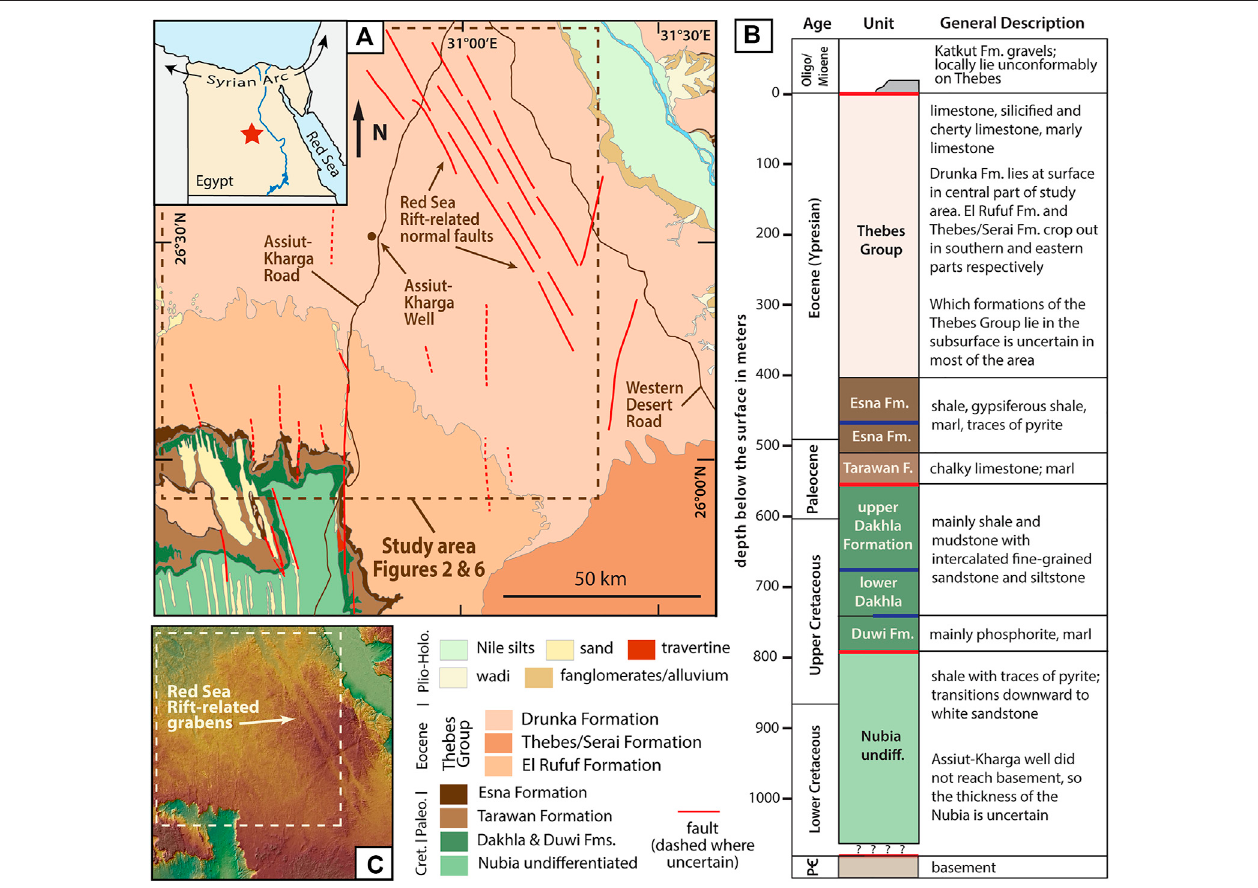
FIGURE3|(A) GeneralizedgeologicmapadaptedfromKlitzschetal.(1987),Riadetal.(2005),andGhobrial,1967.Minorfaultsareextremelycommoninthemap area; we have shown only major faults, which are generalized at this scale. Dashed brown rectangle shows mapping area of this study. (B) Representative stratigraphic column for study area; colors correlate with geologic map in 3A. Colored horizontal lines show general stratigraphic positions of unconformities described by several authors (e.g., Khalifa et al., 2004). Red lines show unconformities where signi fi cant erosion may have occurred. Blue lines designate paraconformities where a depositional hiatus occurred but without subaerial erosion. Half lineat top of the Duwi shows a local paraconformity. Oligocene/Miocene Katkut Formation is included in the stratigraphic column but not the geologic map (3A), because Katkut gravels have not been reliably mapped across the Limestone Plateau. Depths to speci fi c formations are based primarily on Assiut-Kharga well (Barakat and Asaad, 1965), located in the middle of our study area. Data from El-Azabi and Farouk (2011), King et al. (2017), Said (1960, 1962, 1990), El Hinnawi et al. (1978), Issawi (1972), Issawi et al. (2009), Keheila and El-Ayyat (1990), Khalil and El-Younsy (2003), Keheila et al. (1990), and El Hinnawi et al. (2005). Reprinted from Tewksbury et al. (2017a) with permission from Elsevier. (C) Colorized shaded relief map for same area shown in 3A, with illumination direction from the NW. Dashed tan rectangle shows mapping area of this study. Elevation model data source: Shuttle Radar Topography Mission (SRTM) digital elevation